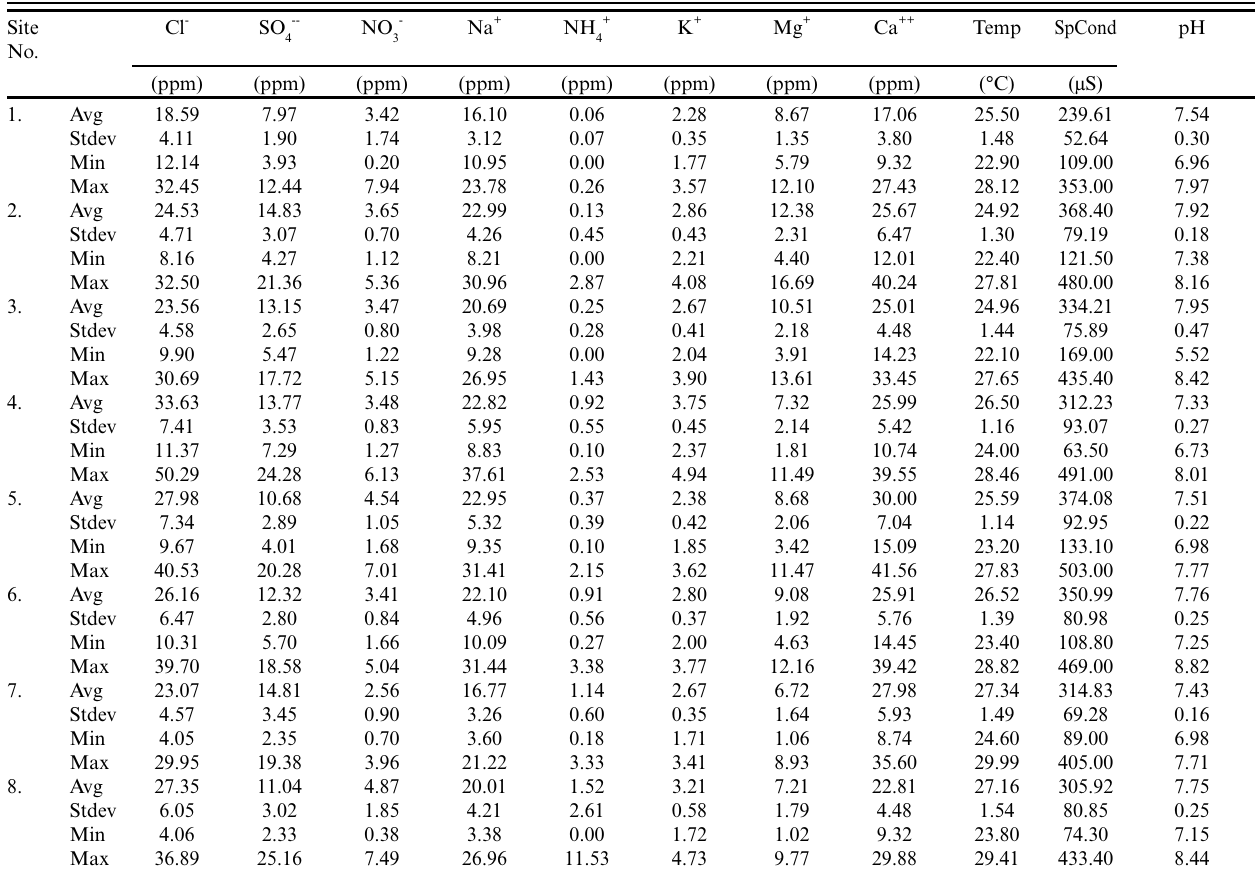
Table 2 . Mean chemical concentration of anions and cations, and physicochemical variables at each study site in the Río Piedras watershed. Site numbers as in Table 1. Cation and anion means are based on 50 collections, except site 9, which is based on 51, and site 8, which is based on 43. Temperature, specific conductivity, and pH means are based on 53 collection dates. Data correspond to weekly collections between 21 April 2011 and 17 April 2012. Avg = average value, Stdev = standard deviation, Min = minimum value, Max = maximum value, Temp = temperature, SpCond = specific conductivity. Site